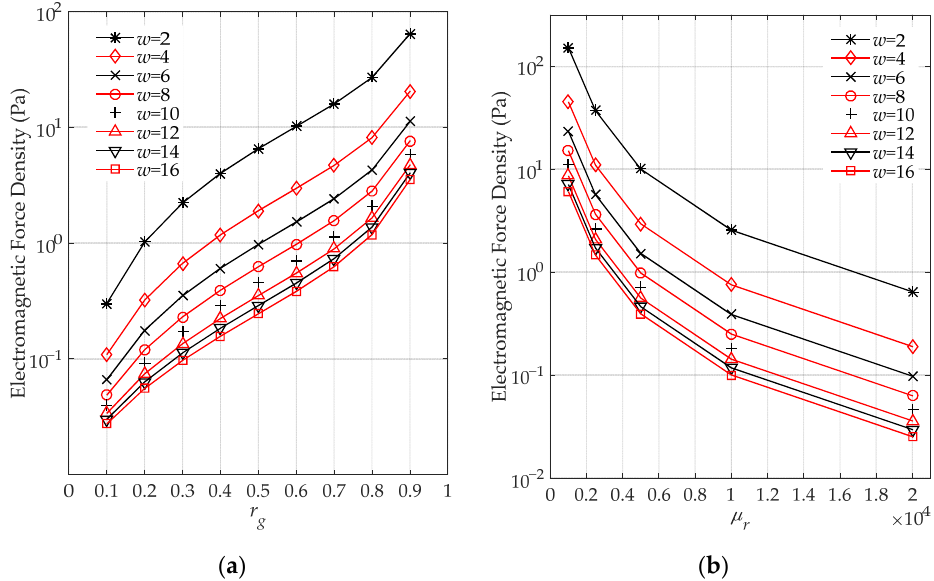
Figure 11. The electromagnetic force density against different air gap ratios and air gap thicknesses when ( a ) µ r = 8000; ( b ) r g = 0.4